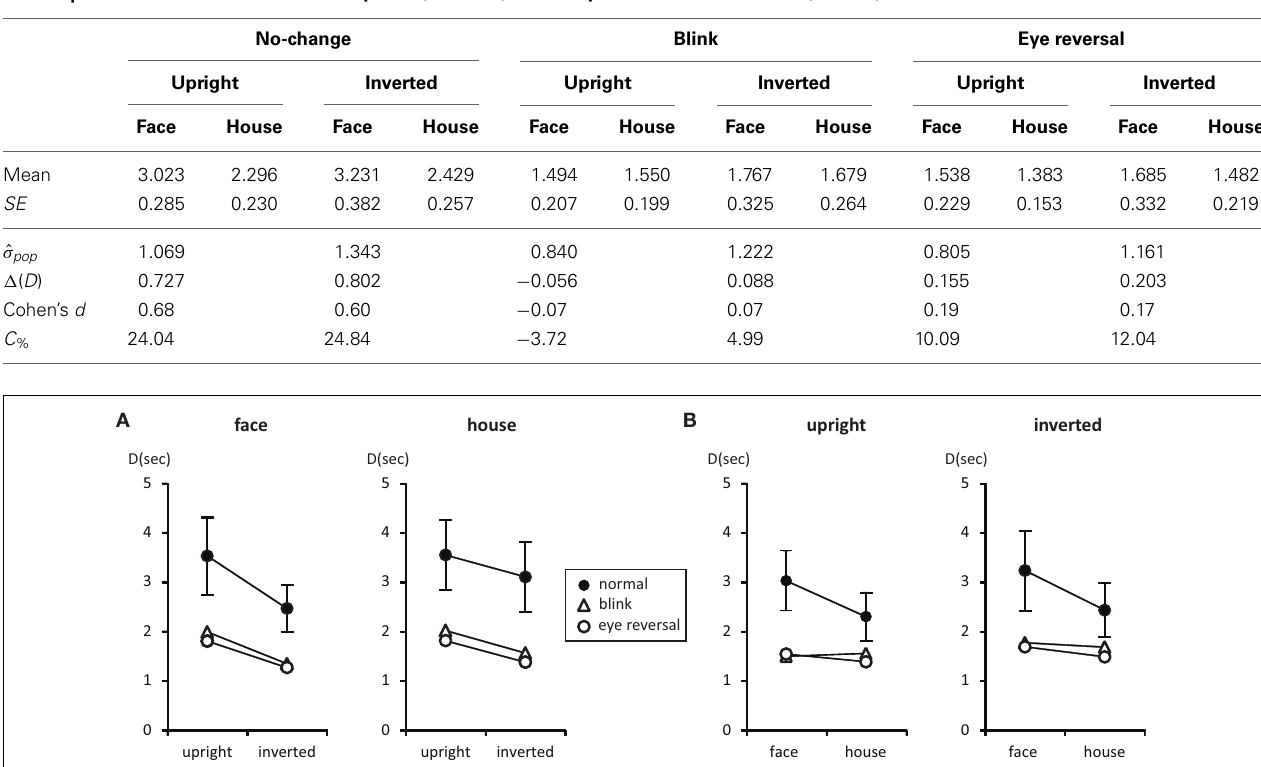
Table 4 | Mean durations of dominance epochs (seconds) for rivalry of faces versus houses ( N = 17).